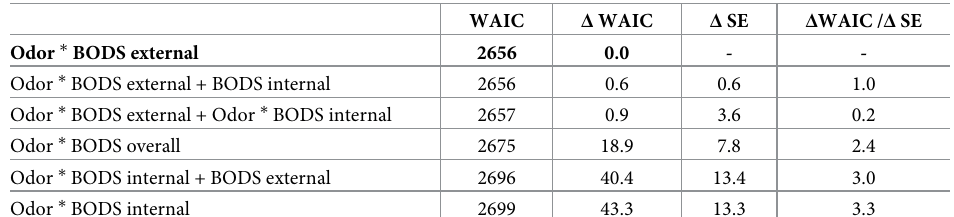
Table 5. Model comparison for models predicting valence